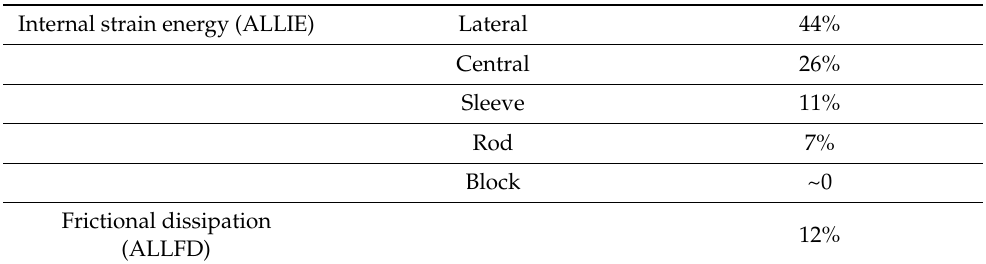
Table 2. Frictional dissipation and distribution of the internal energy (in percentage) between the different parts of the joint.